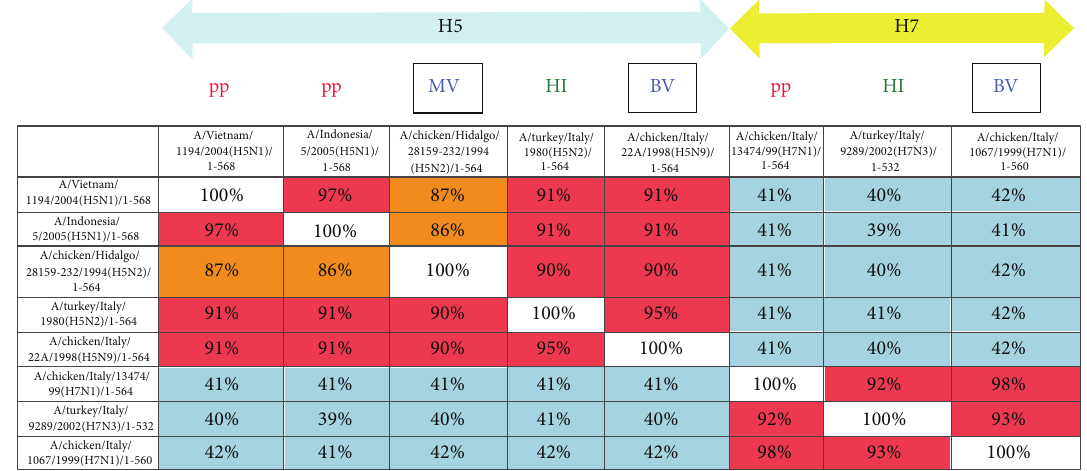
Figure 4: Amino acid identity grid for pseudotype, HI, and vaccine antigen strains. MV: monovalent vaccine antigen, BV: bivalent vaccine antigen, pp: pseudotype antigen, and HI: haemagglutination inhibition assay